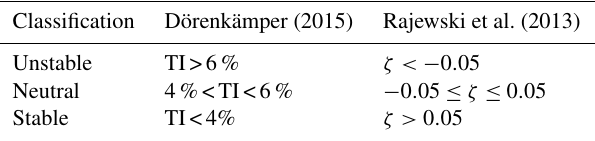
Table 1. Definition of stratification with turbulence intensity and the dimensionless Monin–Obukhov length ζ .